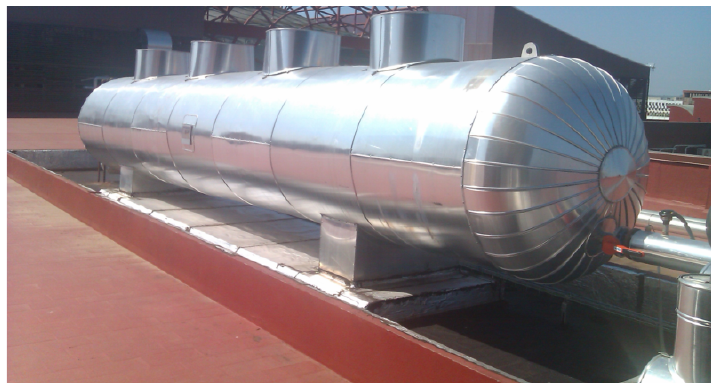
Figure 3. Phase change material (PCM) storage